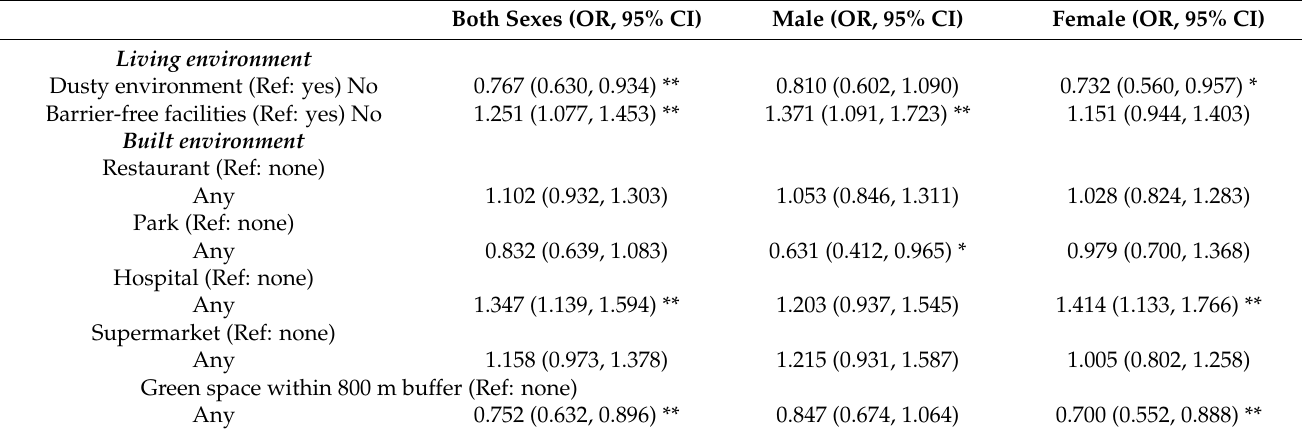
Figure 2. Proportions of the people with and without green space within an 800 m buffer by city (%). The associations between living and built environments and depression symptoms are shown in Table 2. Participants living in a non-dusty environment had a lower risk of depression (OR = 0.767, 95% CI: 0.630, 0.934), although such association existed only among females (OR = 0.732, 95% CI: 0.560, 0.957) and not males. The participants with no access to barrier-free facilities had a higher risk of depression (OR = 1.251, 95% CI: 1.077, 1.453); barrier-free facilities were not associated with depression status among females. General weak and sex-specific associations between built environments and depression symptoms were detected. Male participants who had a park within a 10 min walking distance had a lower risk of depression (OR = 0.631, 95% CI: 0.412, 0.965). Participants who had a hospital within a 10 min walking distance had an elevated risk of depression (OR = 1.347, 95% CI: 1.139, 1.594), and this association seemed to be stronger among fe- males. Participants who had any green space within an 800 m buffer around their homes tended to have a decreased risk of depression (OR = 0.752, 95% CI: 0.632, 0.896), although such a significant association was not found among males. Table 2. Independent associations between each living environmental and built environmental factor and depression, stratified by sex. Both Sexes (OR, 95% CI) Male (OR, 95%